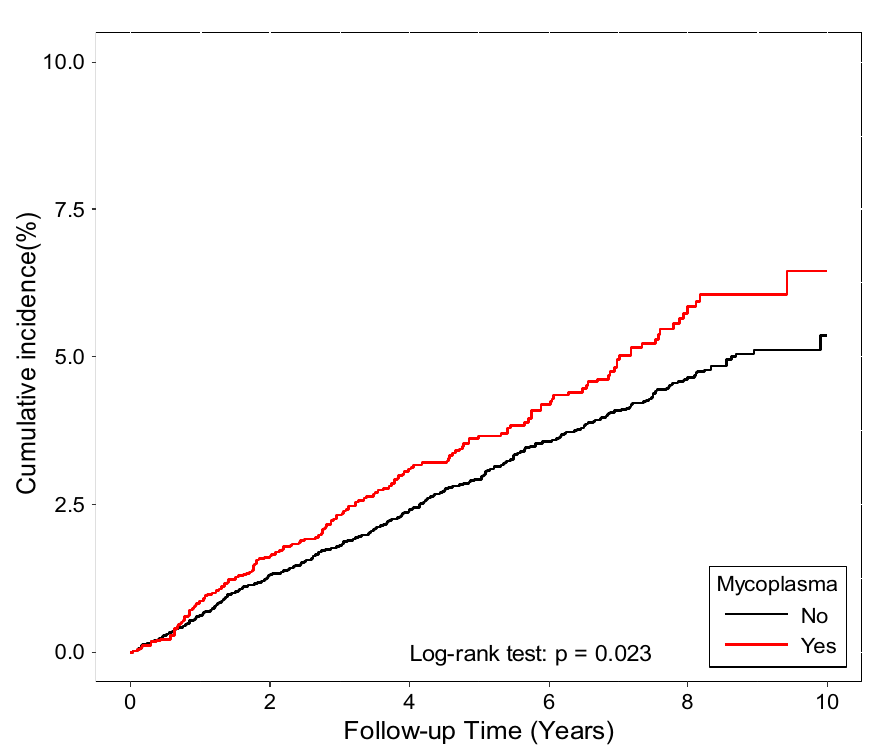
Figure 1. Cumulative incidence of corneal infection in patients with and without Mycoplasma pneumonia